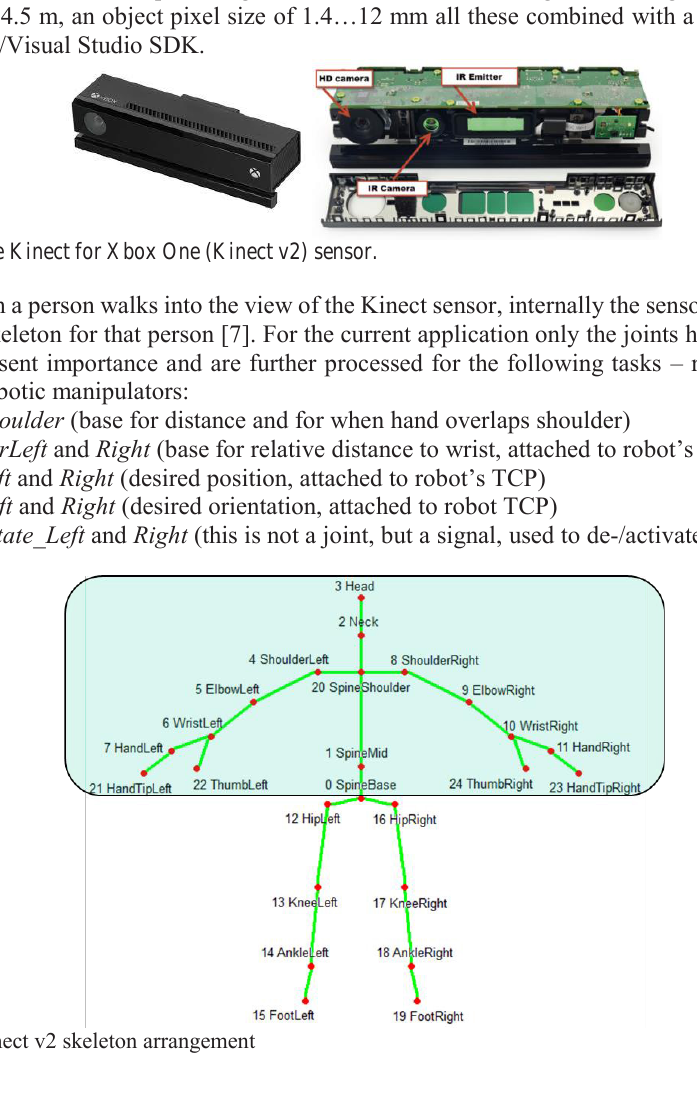
Fig. 3. Kinect v2 skeleton